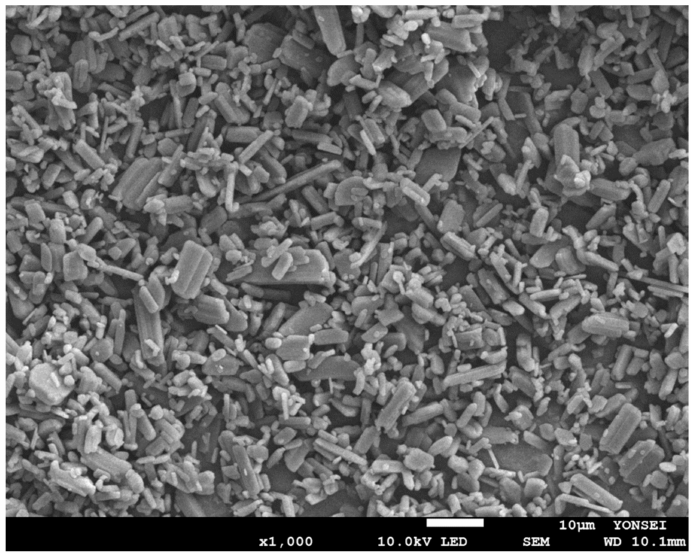
Figure 7. SEM image of raw CEL